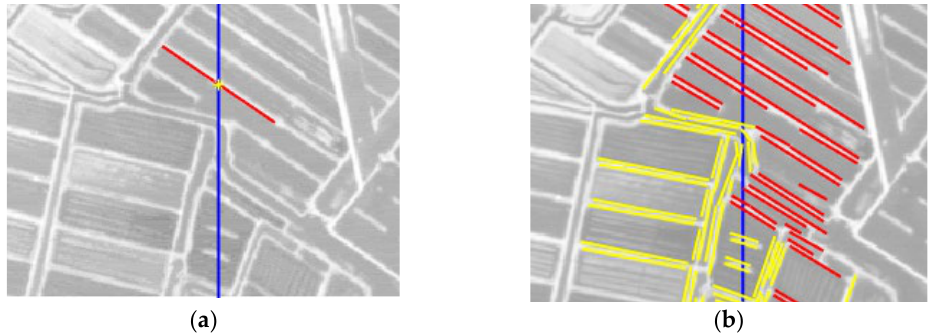
Figure 3. Direction constraint. ( a ) Reference image; ( b ) search image. The blue lines on both images are the corresponding epipolar lines for the midpoint of the L . The red lines in ( b ) are the candidate lines to be retained as satisfying the direction constraint, and the yellow lines are those filtered out by the direction